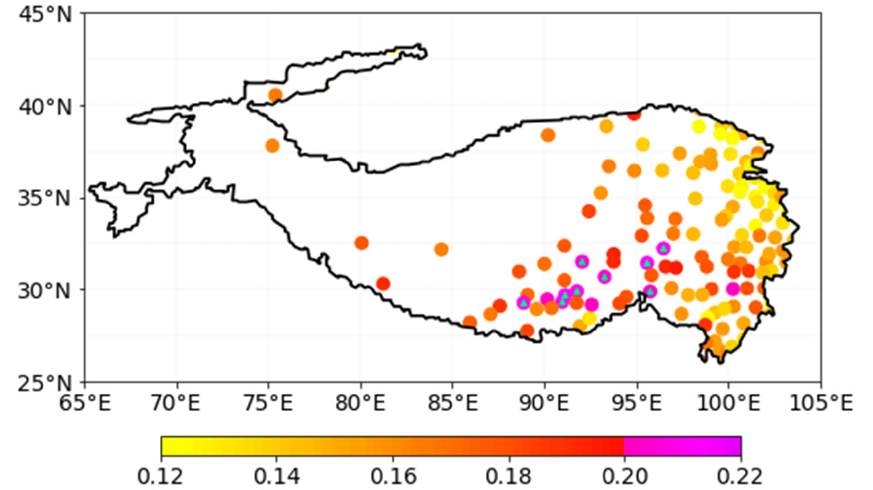
Figure 4. MJO/RMM contribution to the total precipitation variability over TP during boreal summer of 1980–2020. The color circles show the R values derived based on Equation (1). The blue triangles indicate significant R values at the 95% confidence level based on the Student’s t -test.